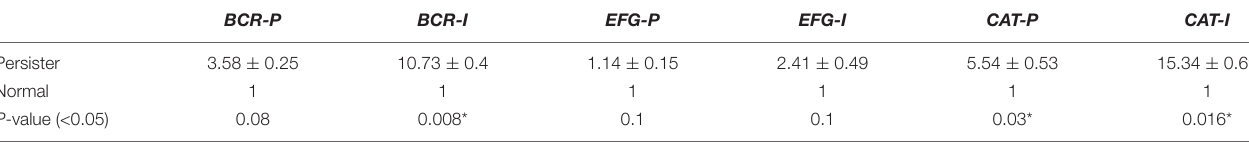
TABLE 5 | Comparison of mean fold change (2 − (cid:49)(cid:49) CT ) in EFG1 , BCR , and CAT1 genes under two conditions: promoting and inducing. BCR-P BCR-I EFG-P EFG-I CAT-P CAT-I Persister 3.58 ±